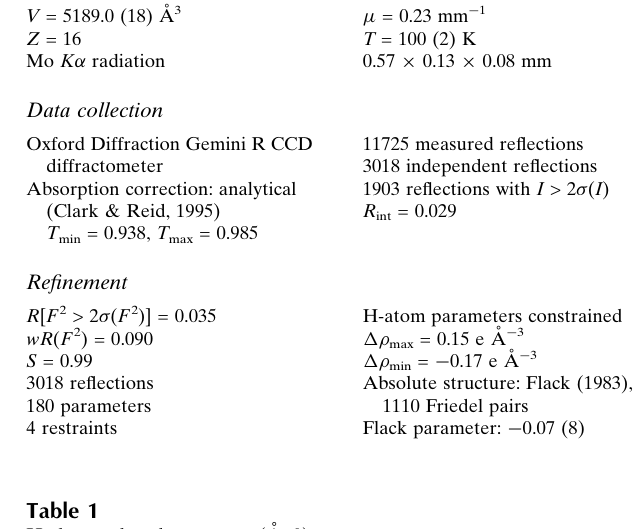
Hydrogen-bond geometry (A˚ , (cid:1)